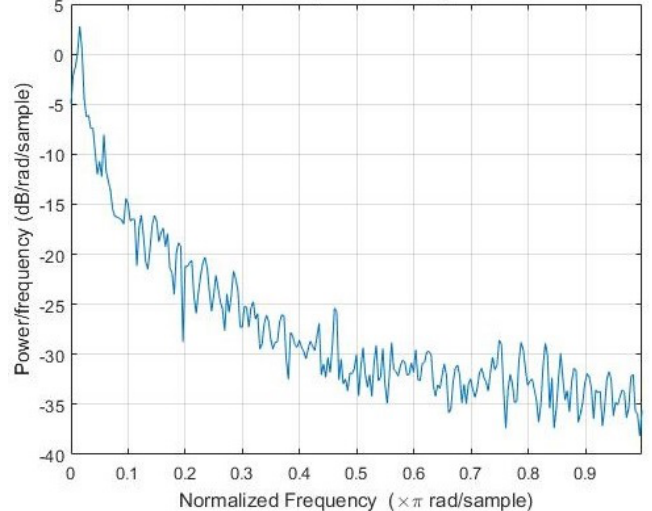
Figure 7. Modified Welch periodogram for the data series B H ( t ) plotted for different values of the frequency.